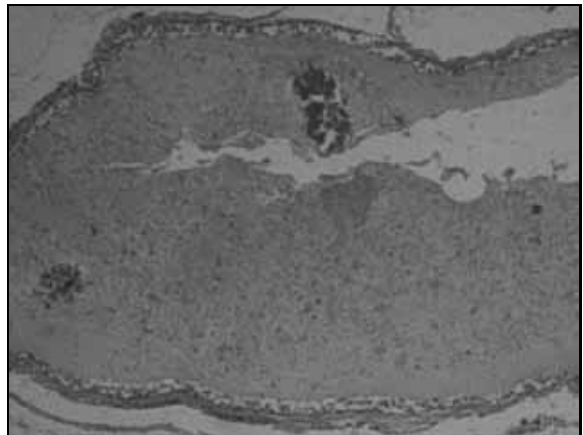
Figura 2 – Microscopia do nódulo que mostra paredes císticas constituídas por tecido fibrocolagênico revestidas por epitélio pseudoestratificado ora cúbico, ora colunar ciliado